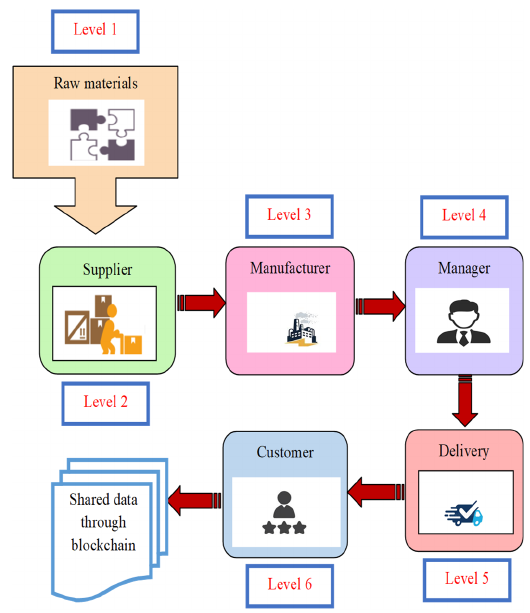
Figure 2. Supply chain network with blockchain.